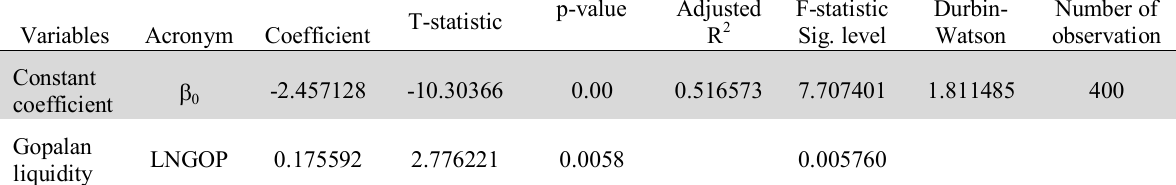
p-value T-statistic